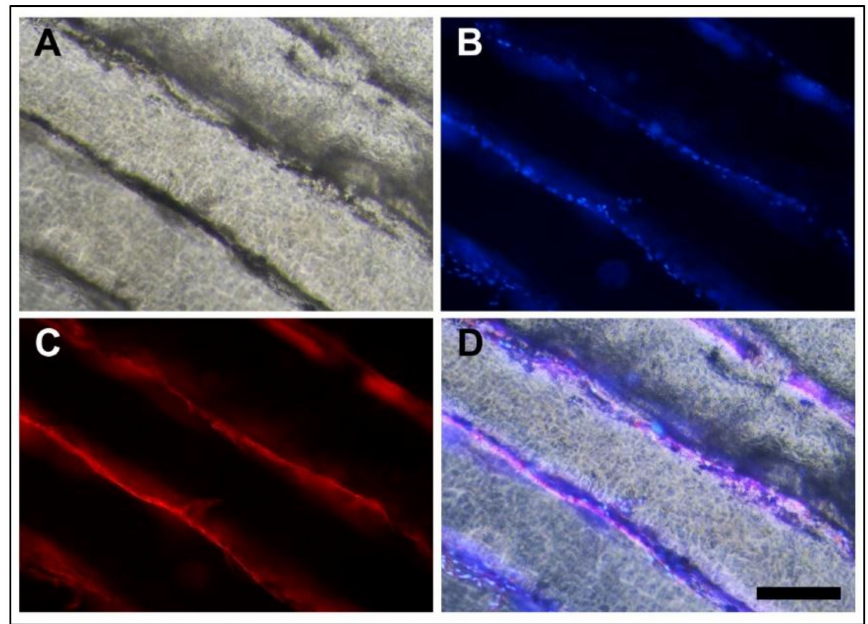
Figure 5. Optical / epifluorescence microscopy of fibers on microchannels after medium change (scale bar 200 µ m). ( A ) Optical microscopy image. ( B ) Epifluorescence microscopy using Hoechst staining (blue shows cell nuclei). ( C ) Epifluorescence microscopy using rhodamine-phalloidin staining (red shows actin). ( D ) Merge of the microscopy